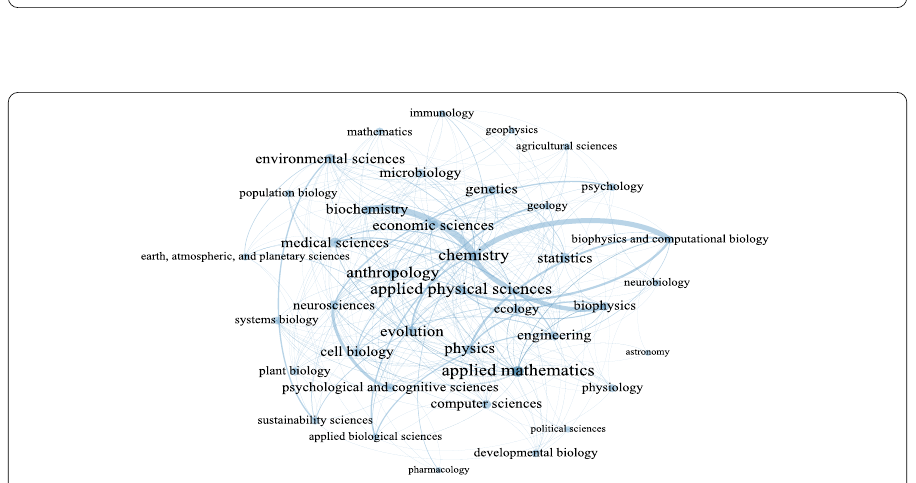
Figure 1 The relationship between the first-class and the second-class disciplines. The network is built based on the discipline information of papers in PNAS 1999–2013. Two disciplines are connected if they are the first-class and the second-class disciplines of a paper. The node size indicates node degree